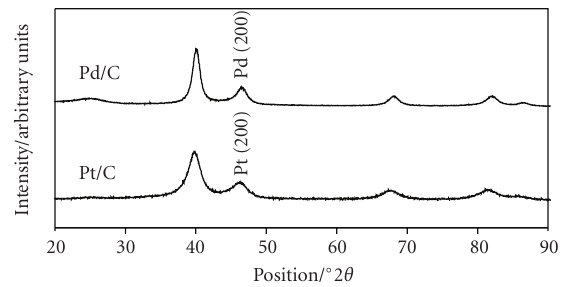
Figure 2: XRD patterns of carbon-supported palladium and platinum